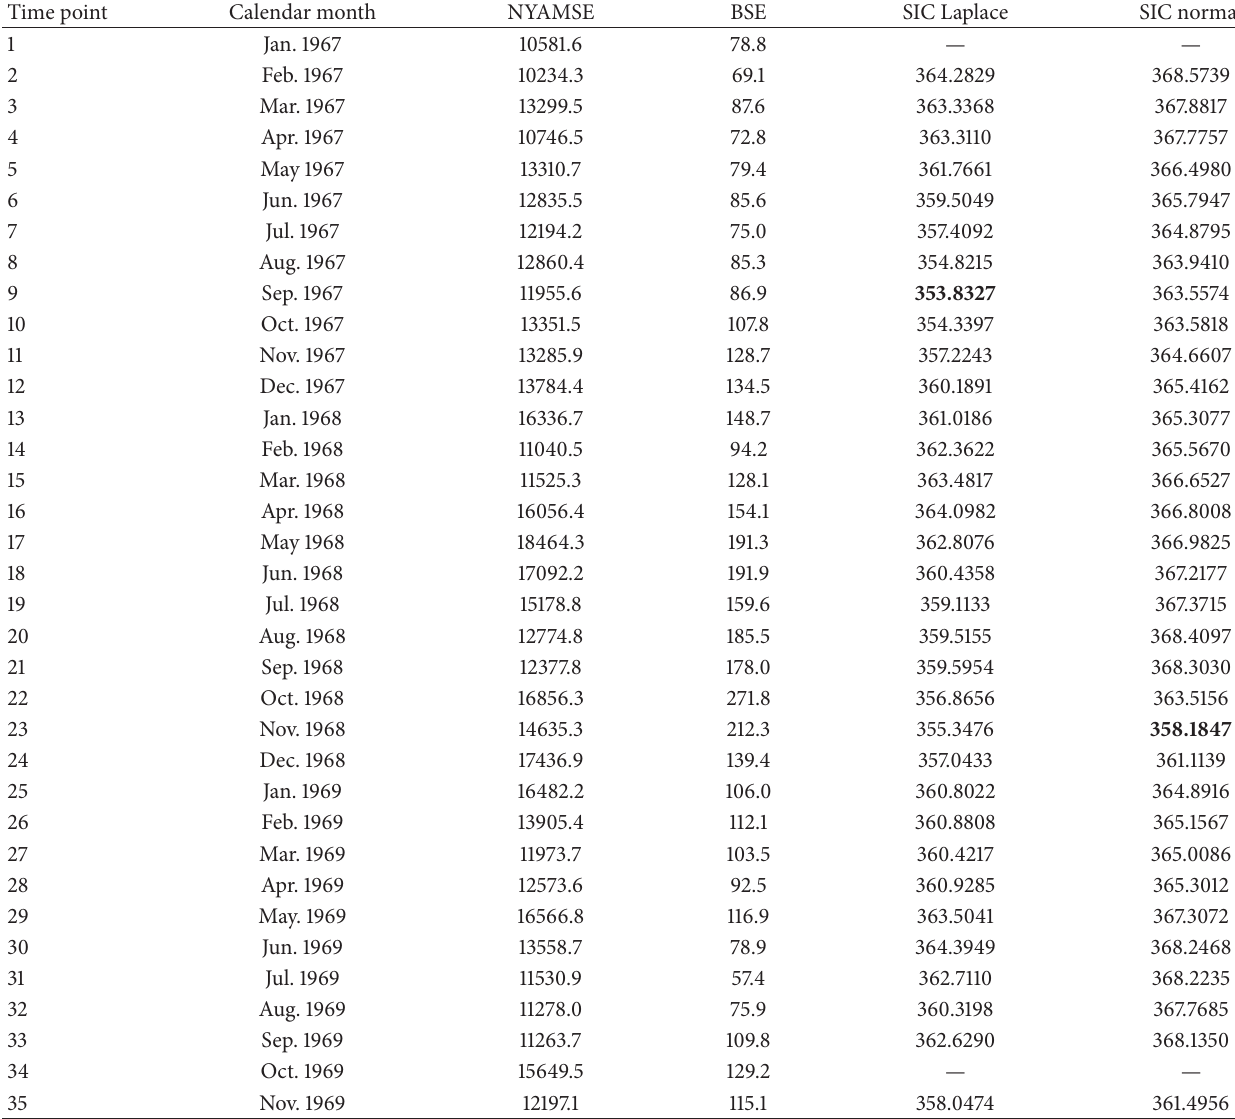
Table 3: SIC calculated by Laplace method and normal method for Holbert data.